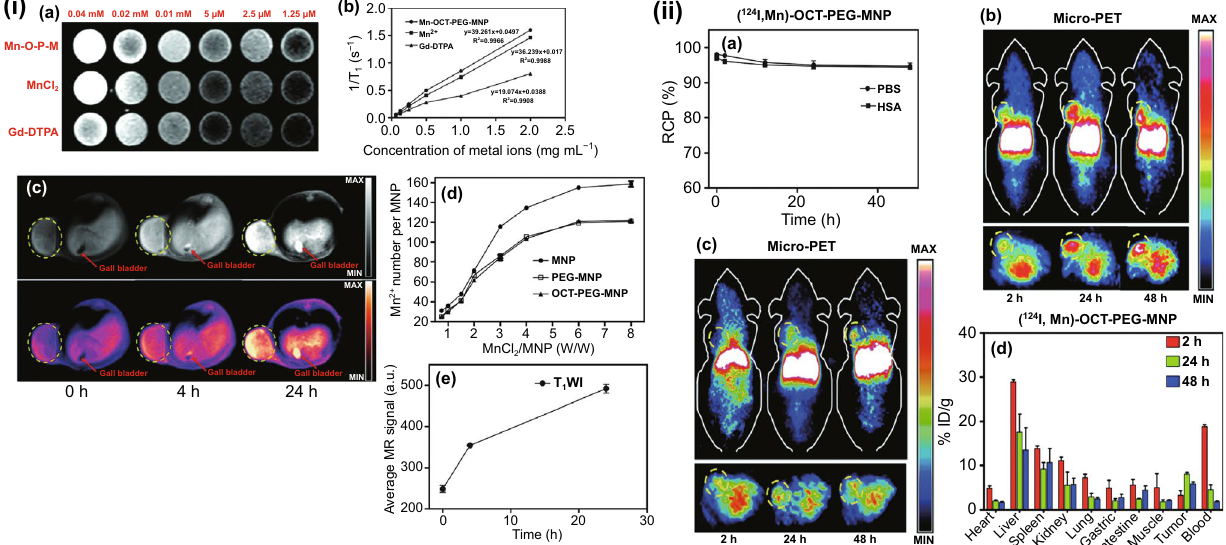
Fig. 4 (i) In vitro and in vivo MRI analysis of Mn 2+ —OCT-PEG-MNPs: a T1-weighted MRI images at 1.5 T, TR: 531 ms, TE: 9.1 ms of Mn 2+ -OCT-PEG-MNPs (upper panel), MnCl2 (middle panel), Gd-DTPA (bottom panel) with various concentrations (2.0, 1.0, 0.5, 0.25, 0.125, and 0.0625 mg mL −1 . b in vitro T1-linear relaxation rates (1/T1, s −1 ) of Mn-OCT-PEG-MNPs, Mn 2+ and Gd-DTPA measured. c Axially imaged T1-weighted MR images of NCI-H469 mice ((tumor site enveloped by a yellow dotted line, and gall bladder was indicated by a red line) before and after i.v, tail injection of Mn 2+ -OCT-PEG-MNPs(TR: 531 ms, TE: 9.1 ms. d Relationship of Mn 2+ attached on one MNP, PEG-MNP, and OCT-PEG-MNP and feed ratio (WMn/WMNPS). e Quantitative analysis of signaling intensity at the tumor site at various time intervals. (ii) 5 PET analysis of 124 I labeled Mn +2 -OCT-PEG-MNPs. a In vitro stability analysis of ( 124 I, Mn +2 )-OCT-PEG-MNPs in 5% HSA solution and PBS (pH = 7.4). b The sagittal plane (upper panel) and transaxial (bottom panel). Micro-PET images of NCI-H69 tumor (tumor site enveloped by a yellow dotted line) scanned at 2, 24, and 48 h after tail vein injection of (124I, Mn +2 )-OCT-PEG-MNP. c Micro-PET imaging of A549 tumor mice at 2, 24, and 48 h after tail intravenous injection of (124I, Mn +2 )-OCT-PEG-MNPs. d Biodistribution of (124I, Mn +2 )-OCT-PEG-MNPs in NCI-H69 tumor mice (n = 3) measured by gamma scintillator at 2, 24, and 48 h after tail vein injection (data expressed as % ID g −1 ± SEM. Adapted from Ref. [278] with permission from The Royal Society of Chemistry, Copyright